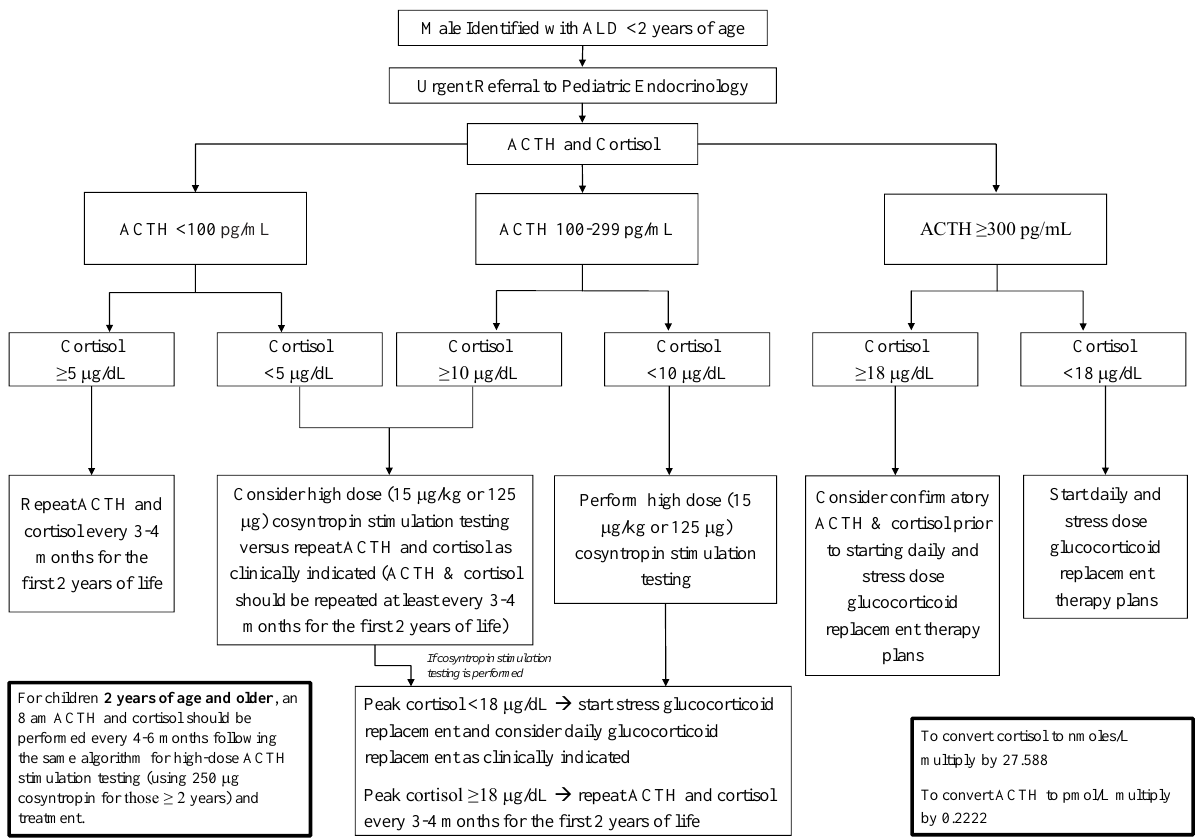
Figure 1. Algorithm for Adrenal Insufficiency Surveillance in Males with ALD. The algorithm at- tempts to address the lack of clear ACTH and cortisol references ranges. Prior to one year, due to the lack of predictable ACTH and cortisol secretory patterns, it may be reasonable to consider per- forming a cosyntropin stimulation test as the initial screen if returning for testing is challenging. ALD, adrenoleukodystrophy; ACTH, adrenocorticotropic hormone. Algorithm reprinted with per- mission [18].